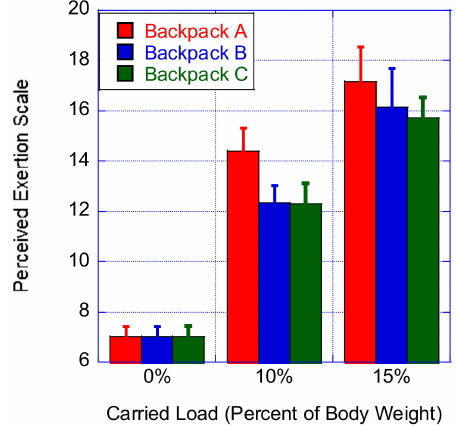
Figure 4. E ff ect of the percent of carried load on the perceived exertion.